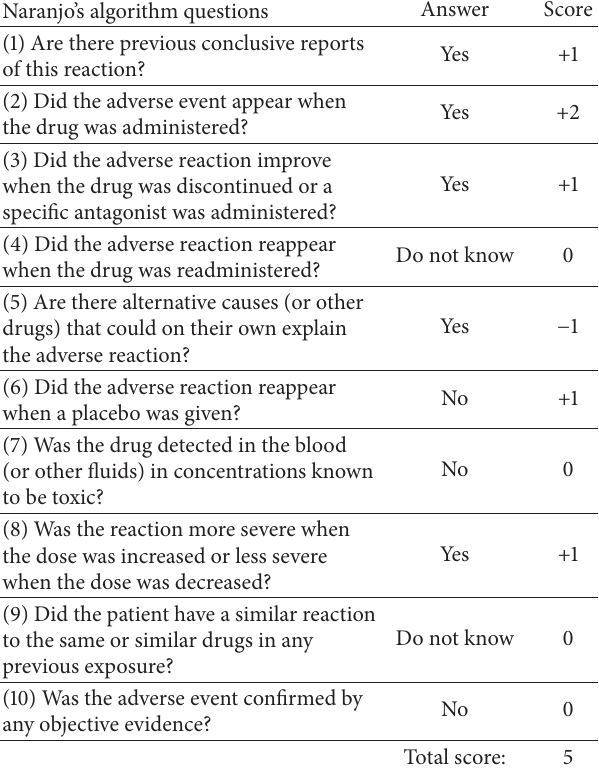
Table 1: Naranjo’s probability scale for our case. Naranjo’s algorithm